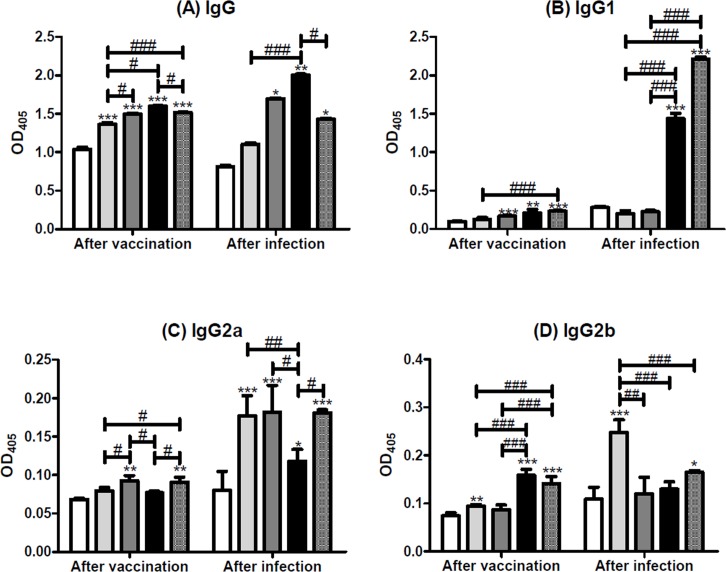
The level of anti-SjGST in serum samples after vaccination and after Schistosoma japonicum challenge.Serum samples were collected from the tails of mice immunized with pcDNA4 (white), pcDNA/SjGST (light grey), pcDNA/SjGST + pIL-12 (dark grey), pcDNA/SjGST + rSjGST (black), or pcDNA/SjGST + pIL-12 + rSjGST (mosaic), 8 weeks after vaccination (left panel) or 8 weeks after infection (right panel). The antibody titers of (A) total IgG, (B) IgG1, (C) IgG2a, and (D) IgG2b were measured by ELISA. The OD405 value of each group was directly shown in the figure. The results are shown as the mean ± standard deviation from three independent experiments. *: p < 0.05; **: p < 0.01; ***: p < 0.001, compared with the control group treated with pcDNA4. #: p < 0.05; ##: p < 0.01; ###: p < 0.001, compared between the two indicated groups.